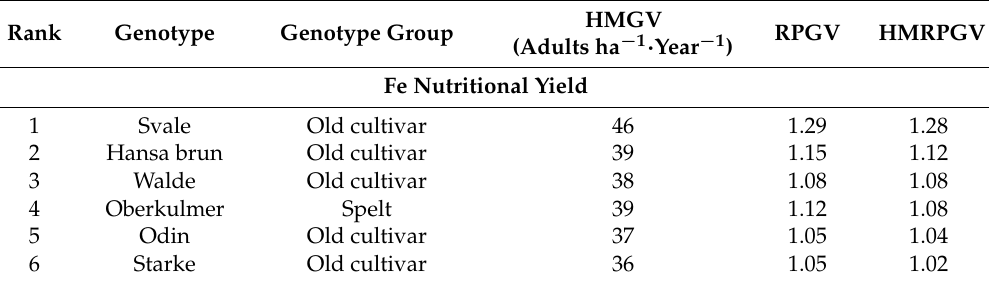
Table 6. Rankings of the winter wheat genotypes with the highest, most adaptable, and most stable nutritional yield of Fe, Zn, Cu, and Mg according to genotypic values (BLUP). Values shown are the harmonic mean of genotypic values (HMGV), which illustrates stability; the relative performance of genotypic values (RPGV), which represents adaptability to unfavorable conditions; and the harmonic mean of relative performance of genotypic values (HMRPGV), which simultaneously denotes high nutritional yield, stability, and